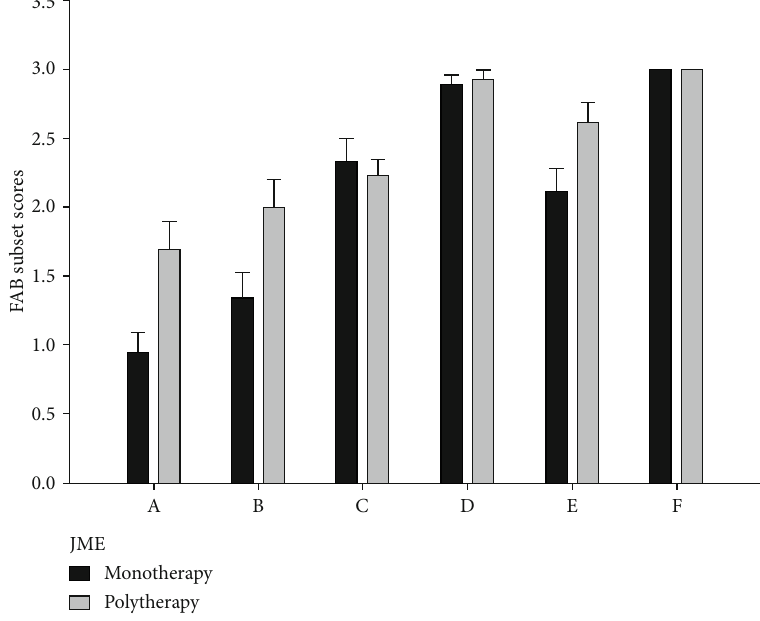
Figure 3: Comparison of FAB subset scores between JME patients on monotherapy and polytherapy regimen. Table 5: Partial correlation between disease duration and FAB scores in JME patients controlling for age, sex, family history, and multiple comparison.